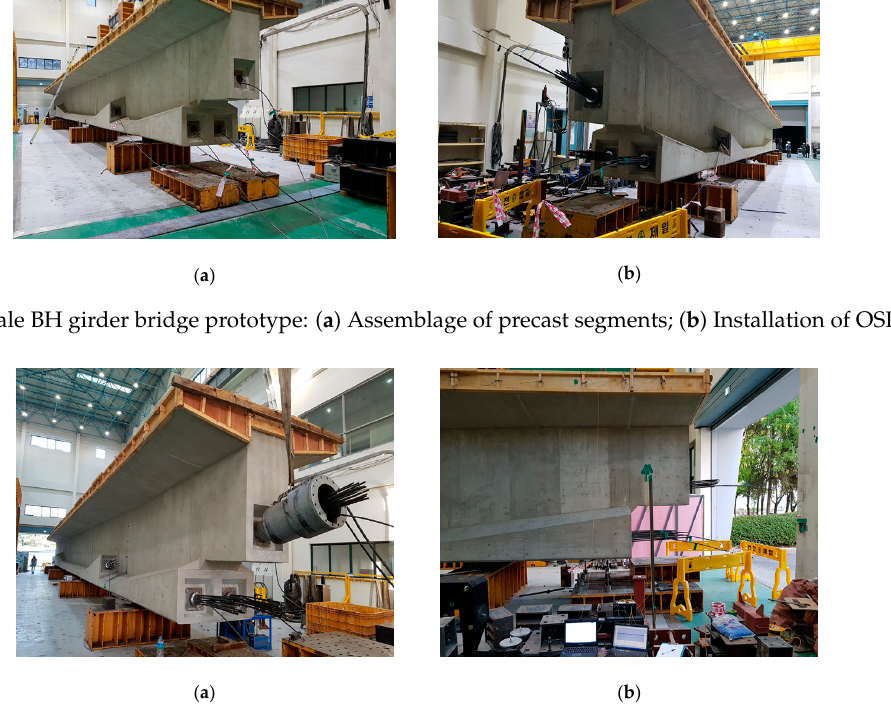
Figure 7. Full-scale BH girder bridge prototype: ( a ) Prestressing process; ( b ) Measurement of prestressing force during tensioning.